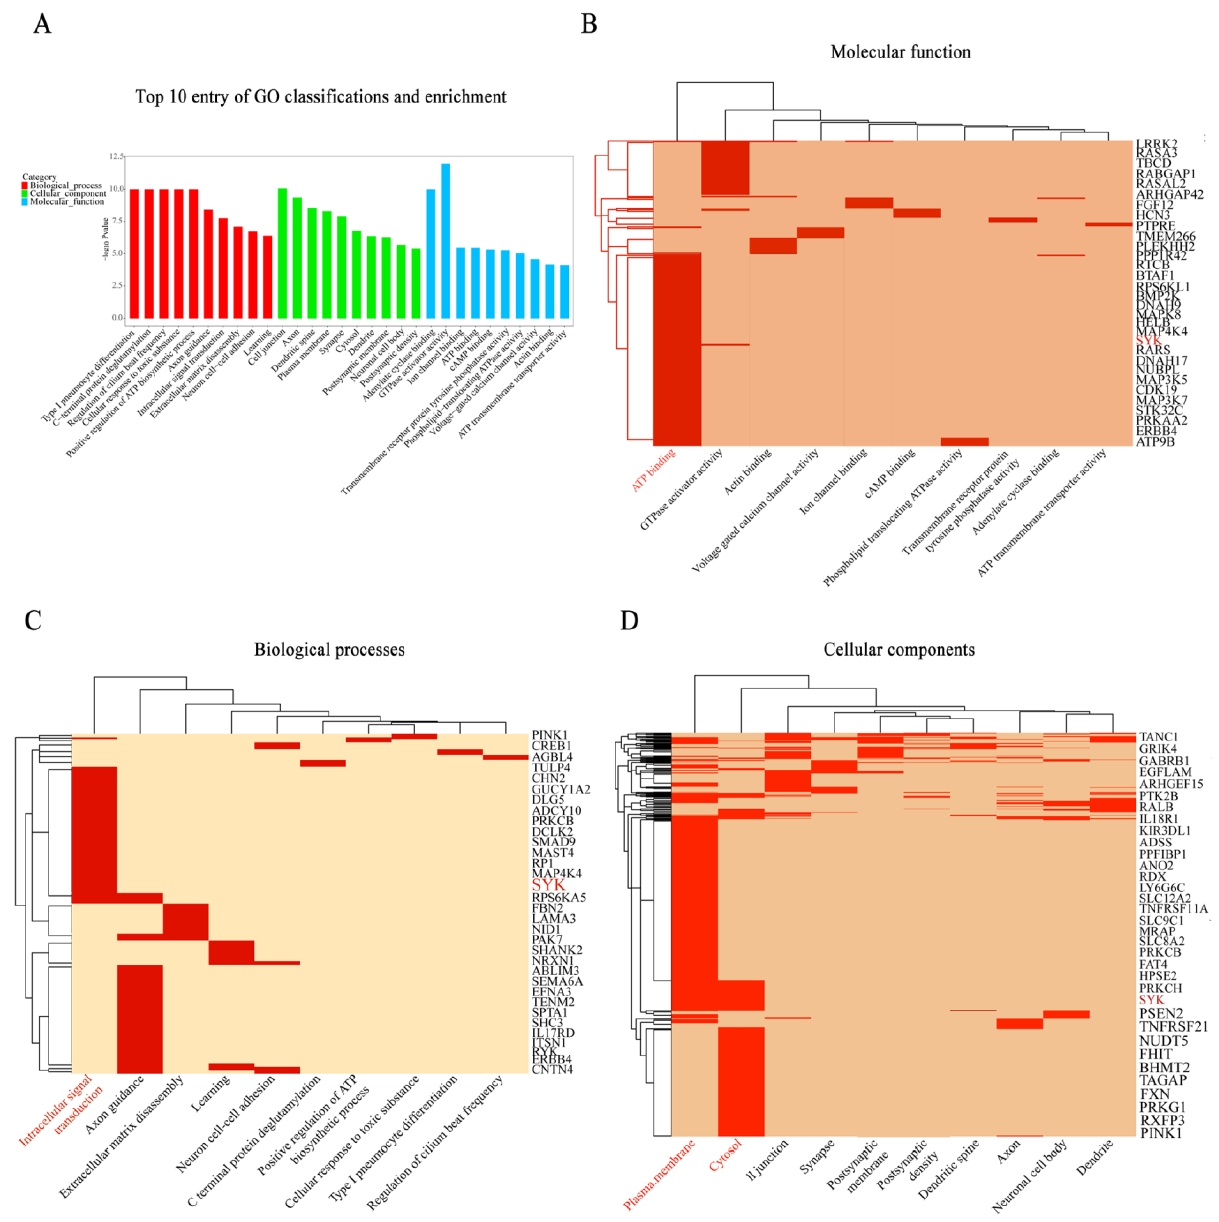
Figure 1. Gene functional annotation and enrichment analysis for bovine mastitis (20 normal cows and 20 mastitis cows). ( A ) The top 10 entry of three GO classifications and enrichment (molecular function, biological processes and cellular components); ( B ) gene list of the molecular function: SYK in the ATP binding entry (red marker); ( C ) gene list of the biological processes: SYK in the plasma membrane and cytosol entry (red marker); ( D ) gene list of the biological processes: SYK in the plasma membrane and cytosol entry (red marker).